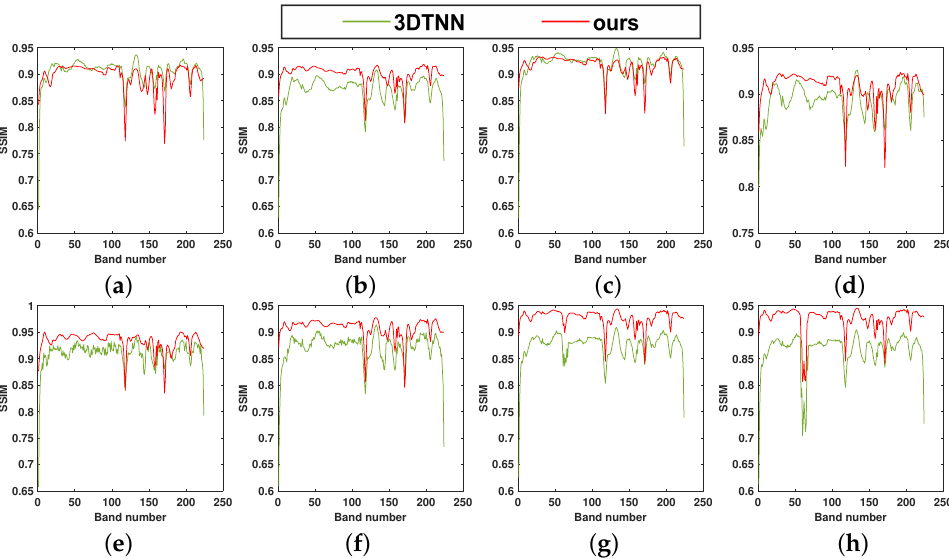
Figure 11. The SSIM values of each band in the dataset-2 after denoising by 3DTNN and our model under ( a ) case 1, ( b ) case 2, ( c ) case 3, ( d ) case 4, ( e ) case 5, ( f ) case 6, ( g ) case 7, ( h ) case 8.